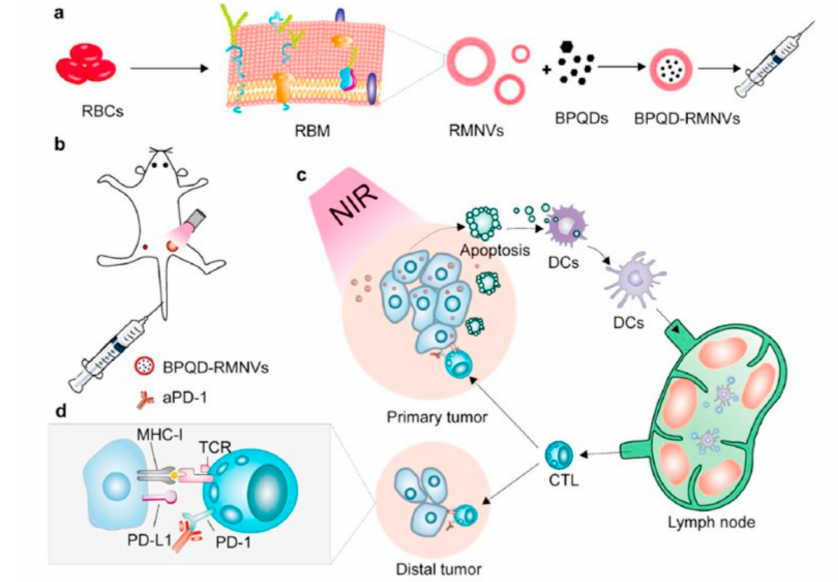
Figure 6. Schematic drawing of preparation of black phosphorous quantum dot (BPQDs) coated with RBC membrane ( a ); treatment of 4T1 tumor bearing mouse using BPQD coated with RBC membranes, aPD-1 and NIR ( b ); apoptosis of cancer cell and release of tumor antigens, dendritic cells (DC) recruitment for the exhibition of antigens to T-cells ( c ); aPD-1 working to keep tumor-infiltrating CD8 + T cells ( d ). Reproduced with permission from Ref.